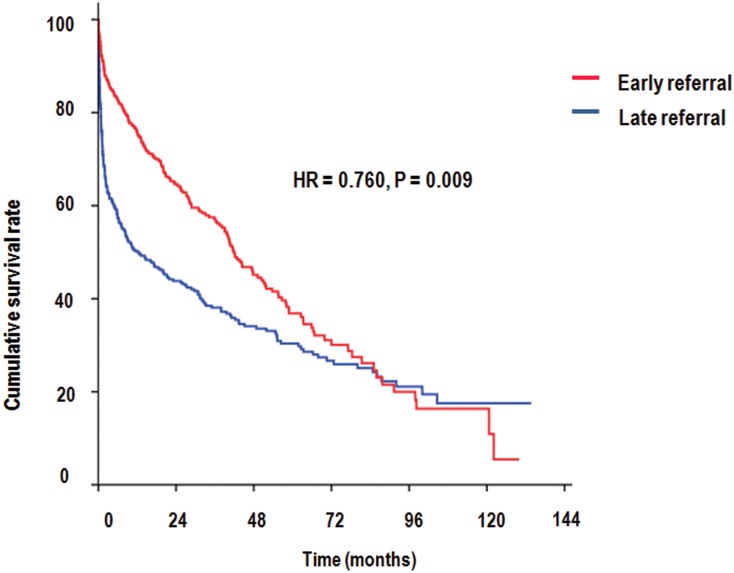
Kaplan—Meier curves for 820 patients with end stage renal disease who initiated hemodialysis during total follow-up period.All-cause mortality rates according to the referral timing.